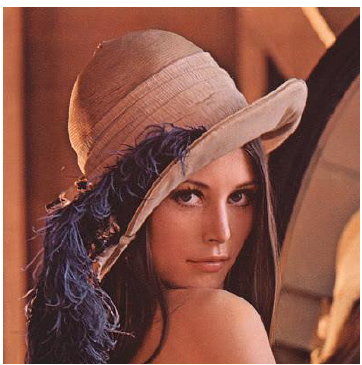
Figure 2. Original image.